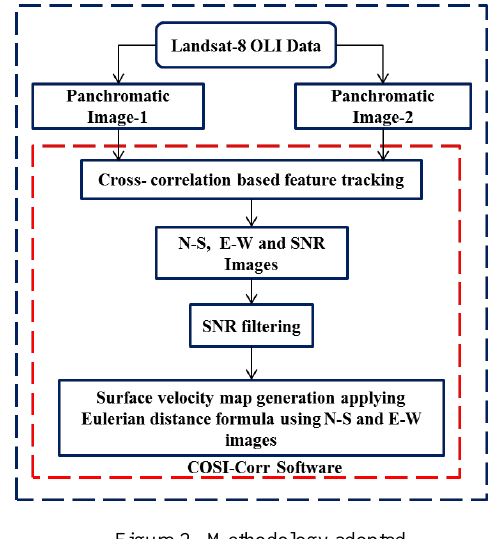
Figure 2. Methodology adopted